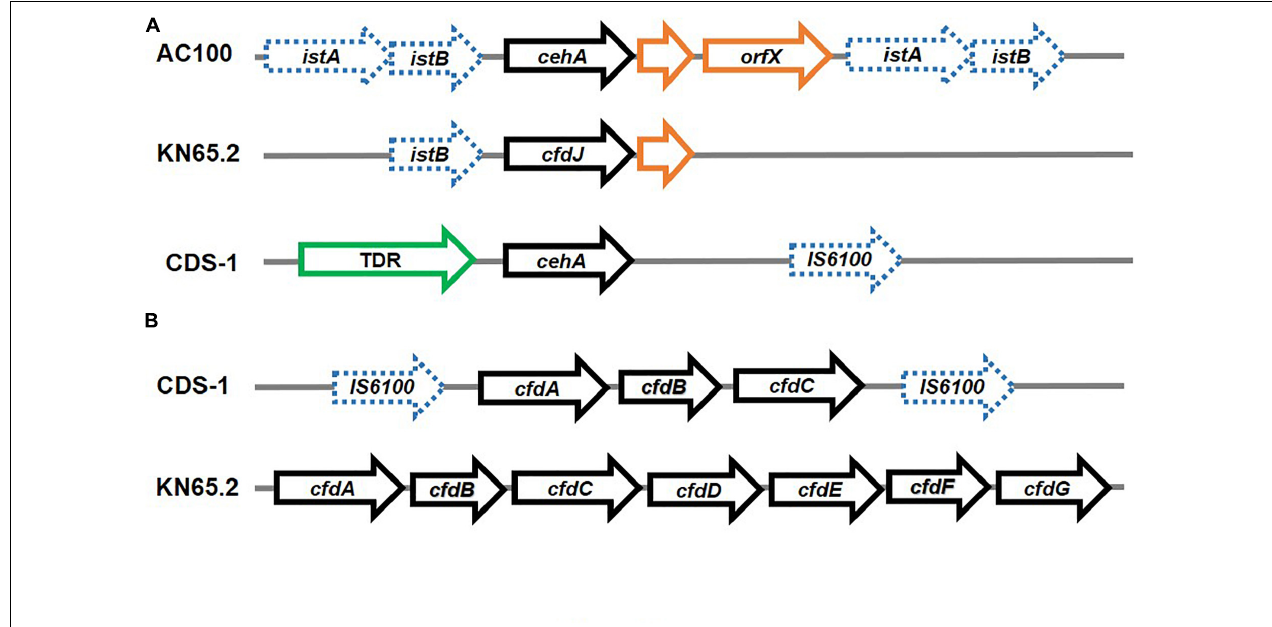
FIGURE 9 | Organisation of genes involved in Carbaryl and carbofuran degradation: (A) Carbaryl hydrolase from Rhizobium sp. AC100 and carbofuran hydrolase genes from Novosphingobium sp. KN65.2 and Sphingomonas sp. CDS-1 – the flanking insertion elements have been depicted as dashed blue arrows whereas the pathway genes are depicted as black solid arrows, whereas ORFs have been depicted in orange and other associated structural genes (TonB dependent receptor; TDR) have been depicted in green and (B) operonic arrangement of genes (depicted as black solid arrows) for carbofuran degradation in Novosphingobium sp. KN65.2 and Sphingomonas sp. CDS-1. The insertion elements have been depicted as dashed blue arrows.